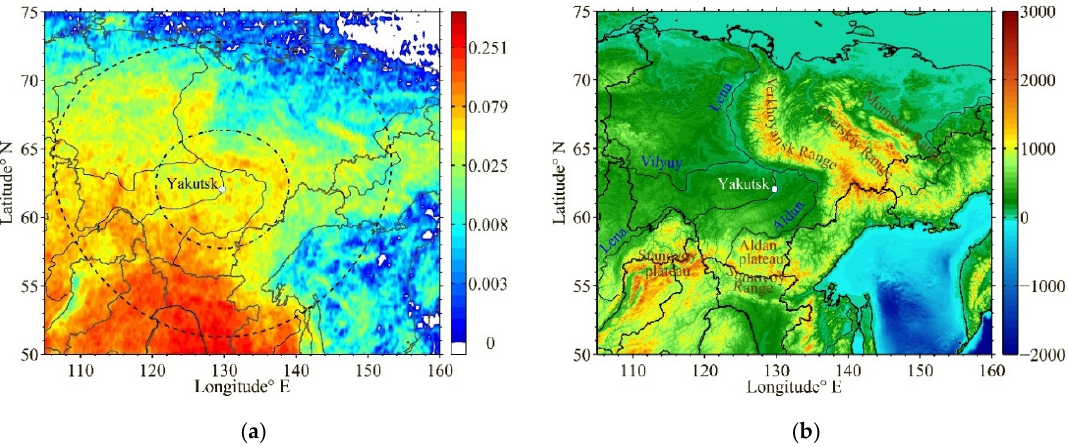
Figure 1. ( a ) Average lightning density spatial distribution in the summers of 2009–2019 according to World Wide Lightning Location Network (WWLLN) data (black dashed line marks an effective detection area of lightning direction finder; black dash-dotted line marks effective detection area of Stormtracker). ( b ) The terrain elevation model [38]; the white circle indicates the location of Yakutsk.